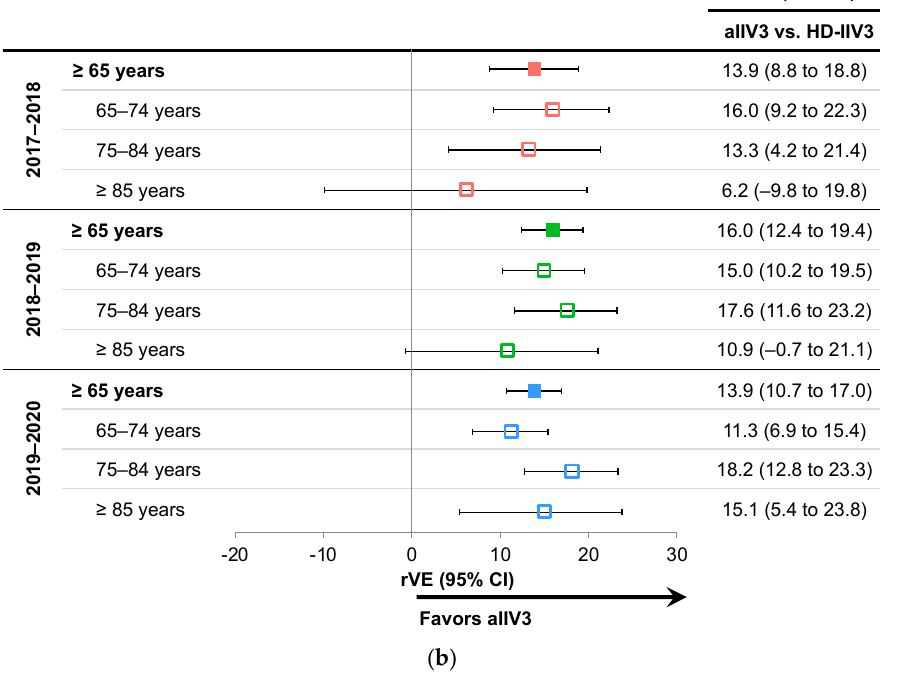
Figure 3. Relative vaccine effectiveness (rVE) of adjuvanted trivalent inactivated influenza vaccine (aIIV3) vs. comparators for the prevention of influenza related medical encounters during the three influenza seasons between 2017 and 2020 in subjects ≥ 65 years of age and by age subgroups [22,24]. ( a ) aIIV3 vs. egg-based quadrivalent inactivated influenza vaccine (IIV4e); ( b ) rVE for aIIV3 vs. high-dose trivalent inactivated influenza vaccine (HD-IIV3). CI, confidence interval.